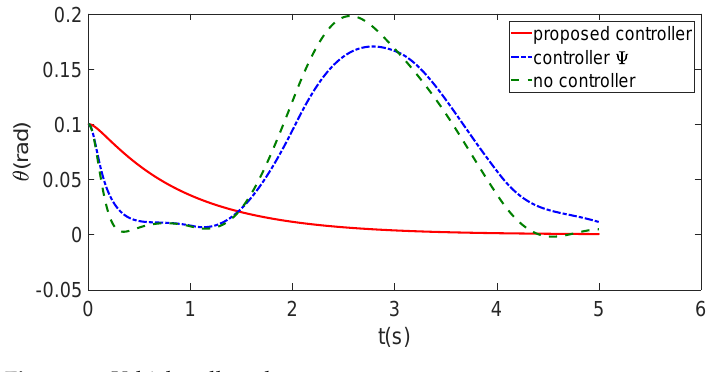
Figure 15. Vehicle roll angle.